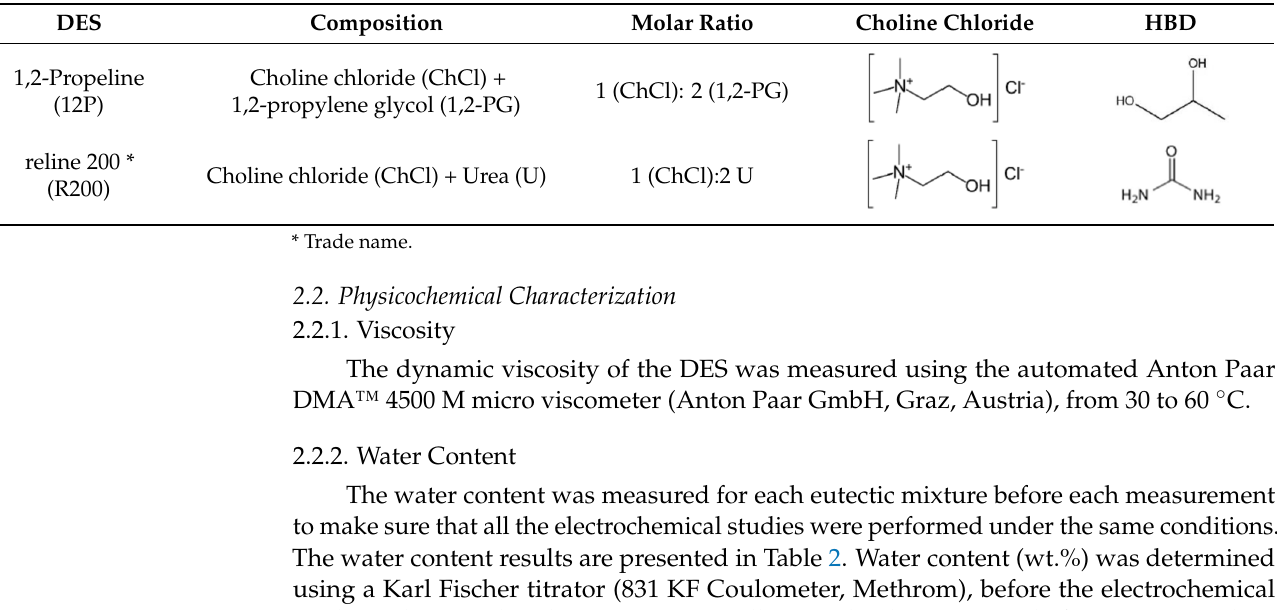
Table 1. Composition and commercial designation of the DES used.